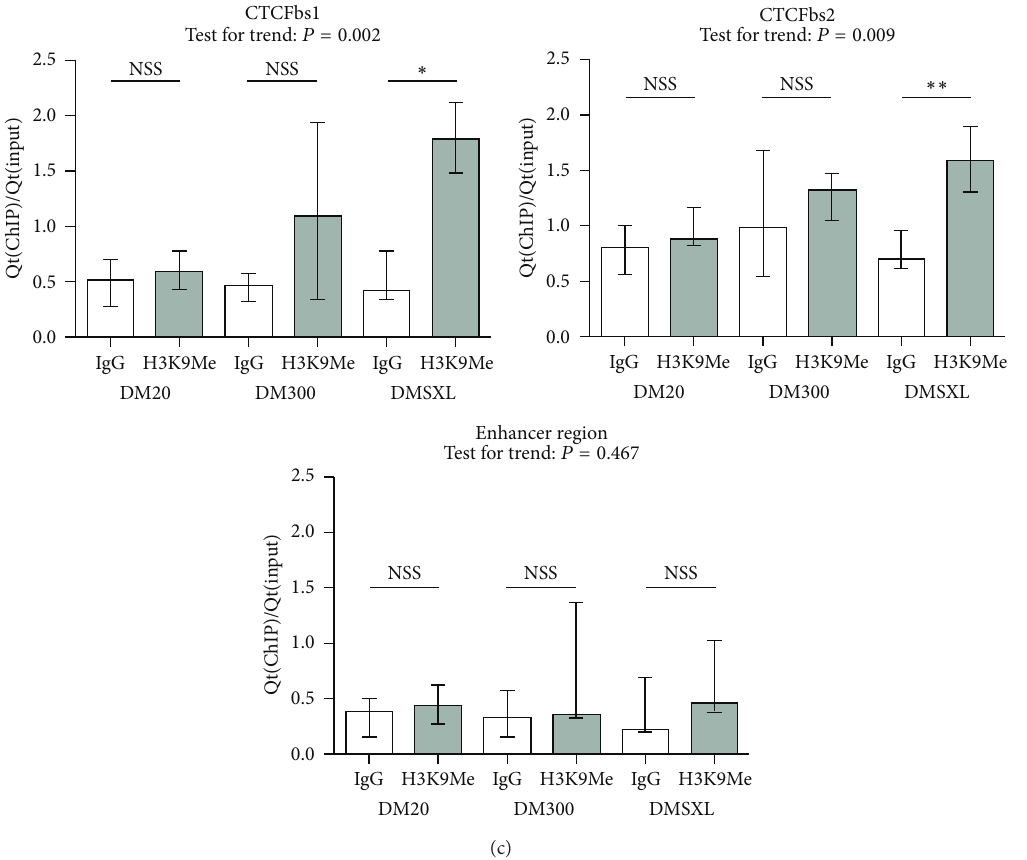
Figure 4: Expanded CTG-repeats are associated with local chromatin remodelling towards a less active chromatin conformation around the CTG-repeat. Less occupancy of active histone marks H3K9/14Ac (H3KAc in graph) (a) and more repressive histone marks (H3K9Me3) (c) around CTCFbs1 and bs2 is observed upon CTG-repeat expansion, while enrichment of repressive mark H3K27Me3 (b) is unaffected. These graphs show enrichment (Qt(IP)/Qt(input), normalised against the abCHIP enrichment value of the positive control amplicon of each respective repeat length category) for different histone modifications in abChIP versus IgG-IP at three regions at the DM1 locus. Height of the bars indicates the median enrichment, and error bars indicate the interquartile range (25th to 75th percentile of observations). Mann-Whitney tests were performed to test for a statistically significant difference between the abChIP and IgG reactions. Results are summarised here with ∗ being 𝑃 < 0.05 , ∗∗ being 𝑃 < 0.01 , and ∗∗∗ being 𝑃 < 0.001 . Details of the statistical analysis can be found in Supplementary Table 1. The enrichment values obtained for the specific abChIP reactions were subjected to the Jonckheere Terpstra test for trend, which tests whether a trend exists across the categories with increasing CTG-repeat length. 𝑃 values are indicated in the graphs and details of this statistical analysis can be found in Supplementary Table